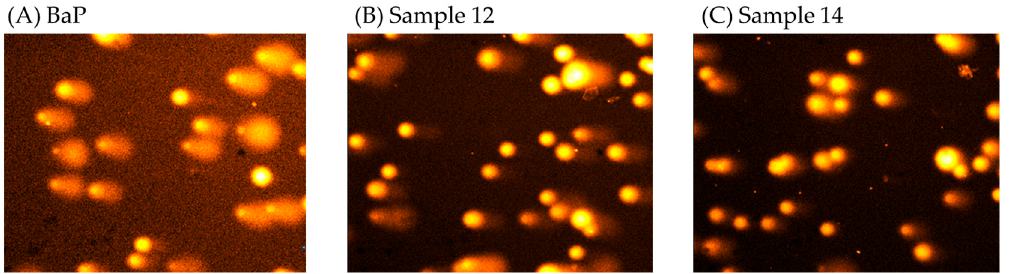
Figure 6. Representative images (10×) of the effect of ( A ), BaP (100 μ M); ( B ), sample 12 (TH + 10RJ + 10PR); and ( C ), sample 14 (CH + 10RJ + 10PR) at 1 μ g/mL on BaP-induced DNA strand breaks in HepG2 cells.